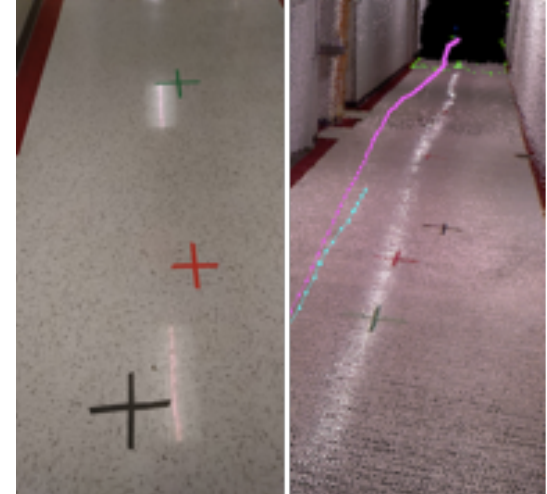
Figure 7. Examples of markers (left), in which CP is denoted in red, Group 2 test point is in black and Group 1 test point is in green; (Right) shows markers in the 3D model.